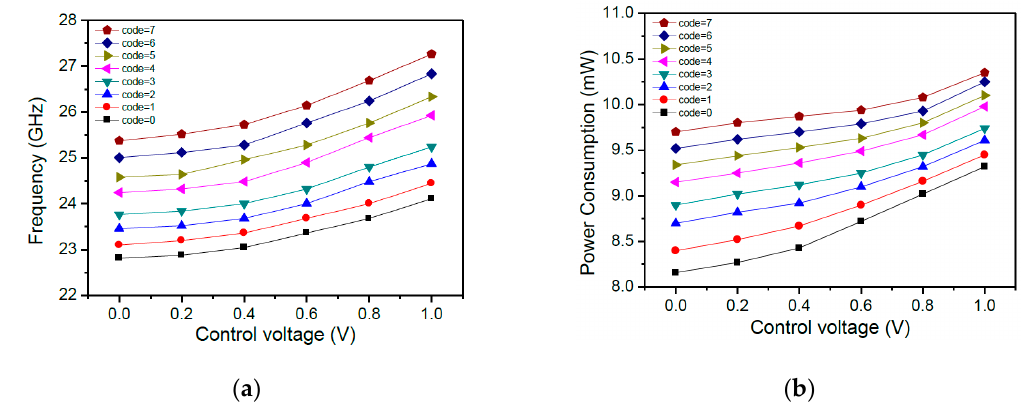
Figure 7. This figure is a plot showing the measured results. ( a ) shows the output frequency according to the VCO 3-bit cap-bank control code and ( b ) shows the power consumption for the output frequency.